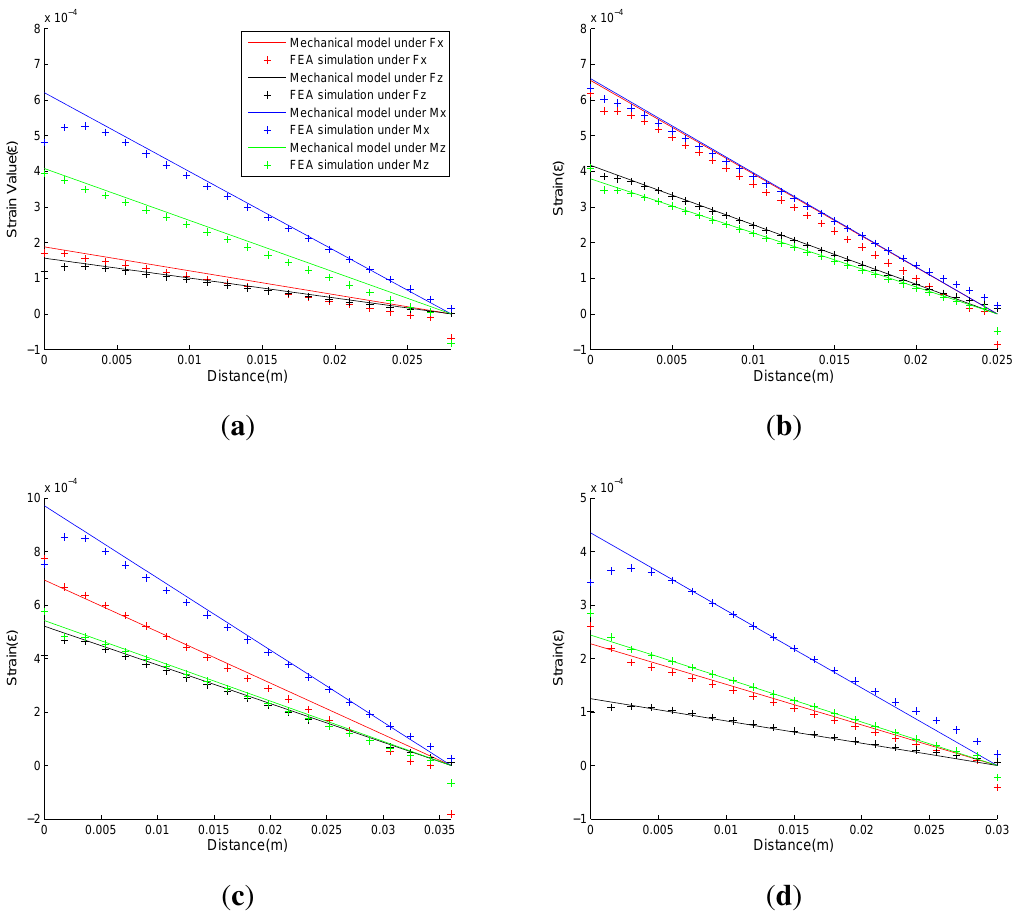
Comparison of analytical solutions and FEA